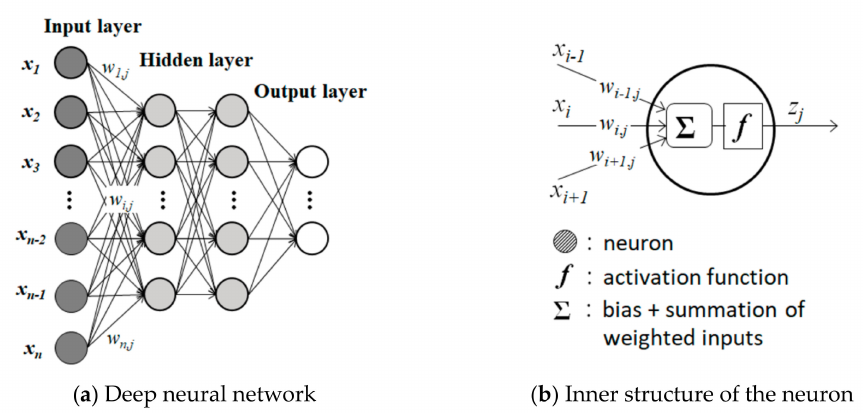
Figure 2. Structures of artificial neural network (ANN) model that show ( a ) data flows in the ANN = neuron) and ( b ) the inner structure of a neuron of j th with i -1th, i th, and i + 1th with deep learning ( (cid:35) inputs with weighed coe ffi cients.